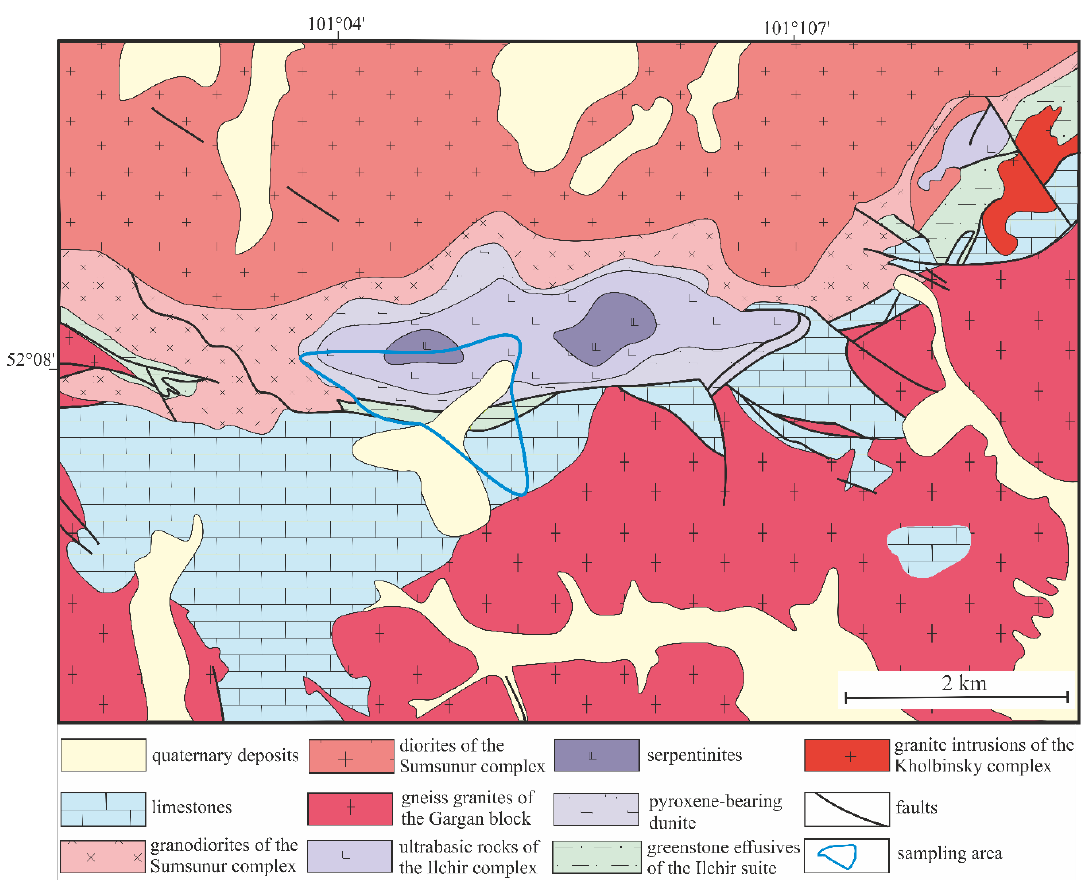
Figure 2. Geological scheme of the Ulan-Sar’dag ophiolite [39] with author additions.